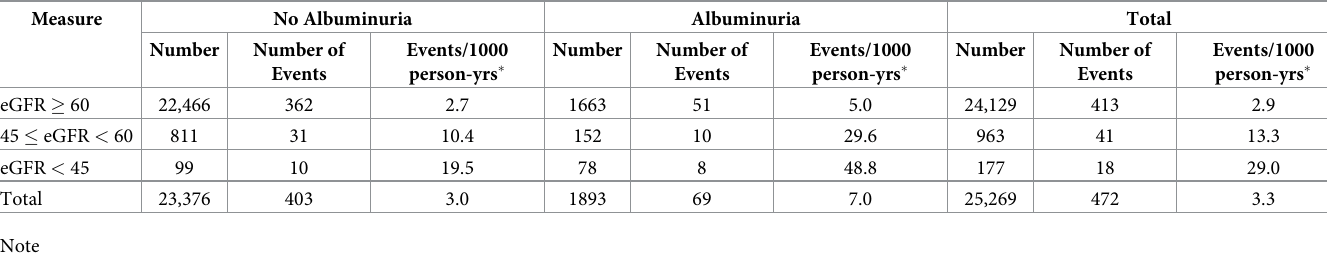
Table 2. Crude Death Rates of the participants from China.